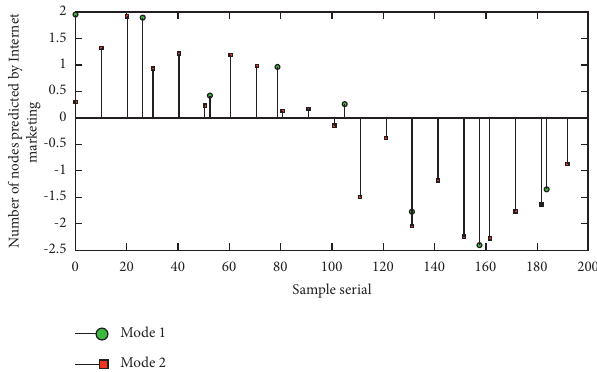
Figure 6: Evaluation of Internet marketing forecast performance.